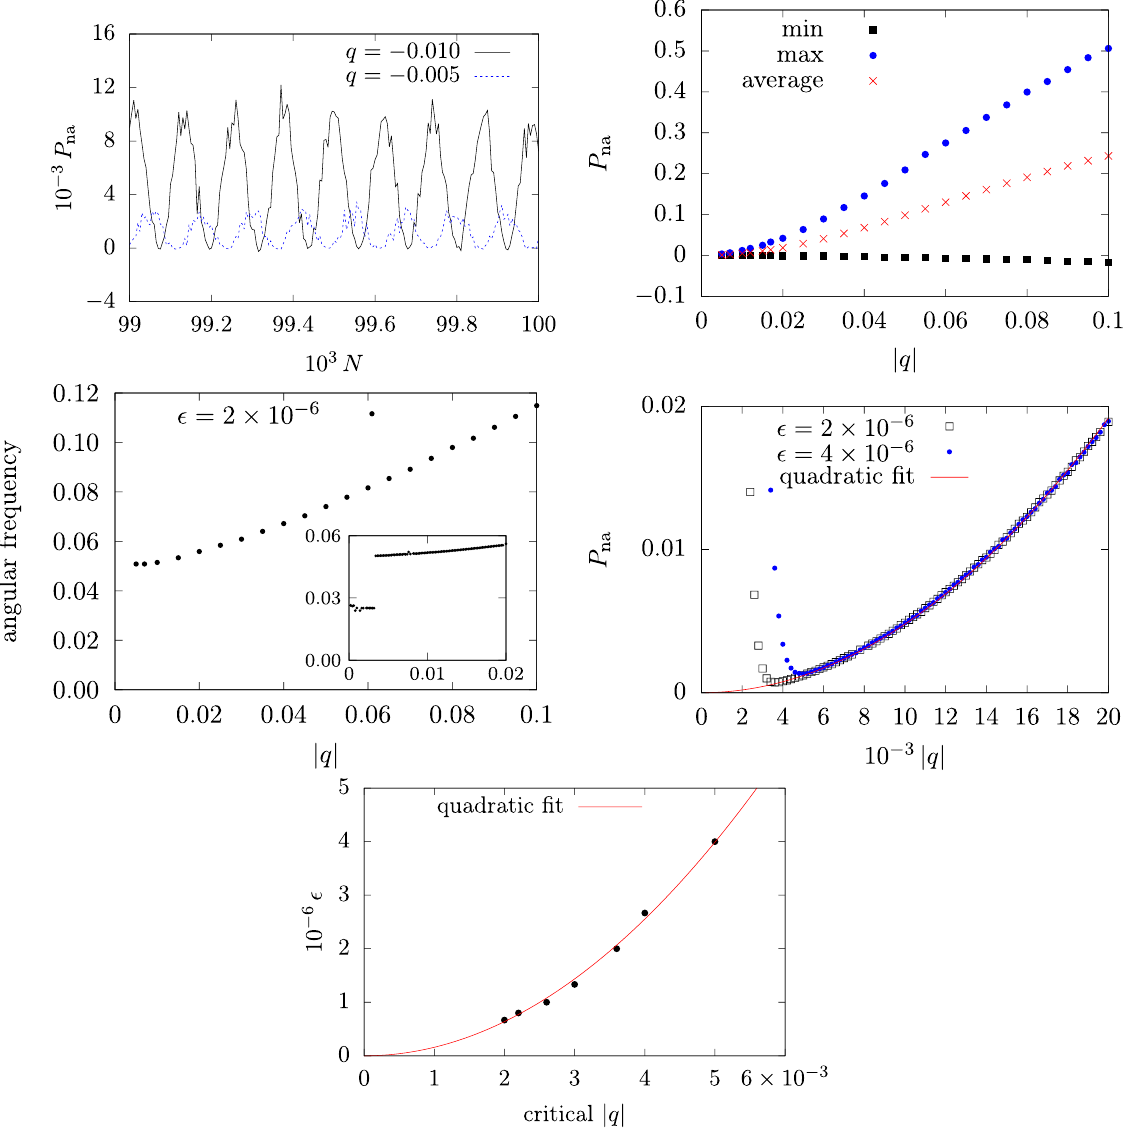
FIG. 5. Top left: Oscillations of P at large values of turns N for different values of q . Top right: Minimum, average, and maximum na for 9 × 10 4 ≤ N ≤ 1 × 10 5 for different values of q . Center right: zoom in the small q region of the average value of P value of P na na with a quadratic fit. Note that for small j q j values the emittance exchange breaks down, which is indicated by P growing toward 1 and na the q -value corresponding to the break down is ϵ -dependent. Center left: main angular frequency of the oscillations of P obtained by a na refined FFT as a function of q . Bottom: relation between the critical value of j q j , for which the break down of P is observed, and ϵ . A na 2 . 602 , quadratic fit to the data is also shown, which confirms the scaling law (63). The map (60) has been used, with parameters ω x ¼ 2 . 5 , ω 2 . 7 , and a set of initial conditions with h I 10 − 4 , h I 4 × 10 − 4 ω x; i i ¼ y; i i ¼ y ; i ¼ y ; f ¼